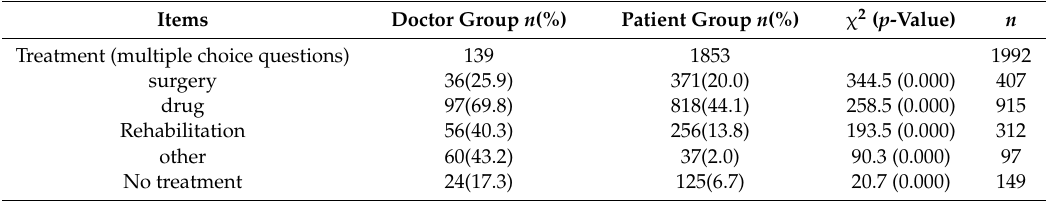
Table A3. Perceptions on treatment types for rare diseases and sources of drugs between two